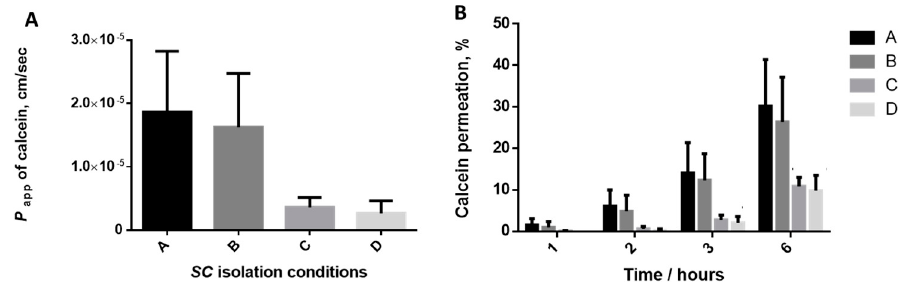
Figure 2. Effect of SC isolation conditions on the permeability of calcein through the pig ear SC . ( A ) Apparent permeability coefficient at 3 h; ( B ) Percentage of permeation of calcein at different timepoints. Error bars represent the mean ± SD for at least three independent experiments. p < 0.05 for Kruskal-Wallis test among the studied SC isolation conditions. Black, dark grey, medium grey and light grey bars correspond to isolation conditions A, B, C and D, respectively.